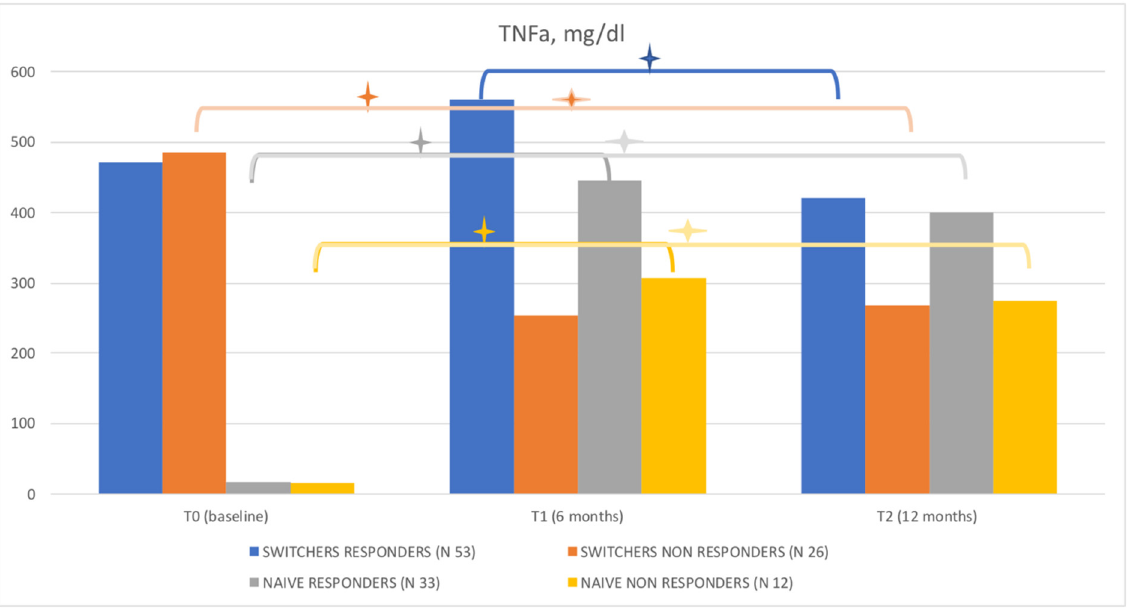
Figure 1. TNF-α levels in naïve patients and switcher responders and non-responders. The plus/star symbol (+) represent p -value = < 0.001.